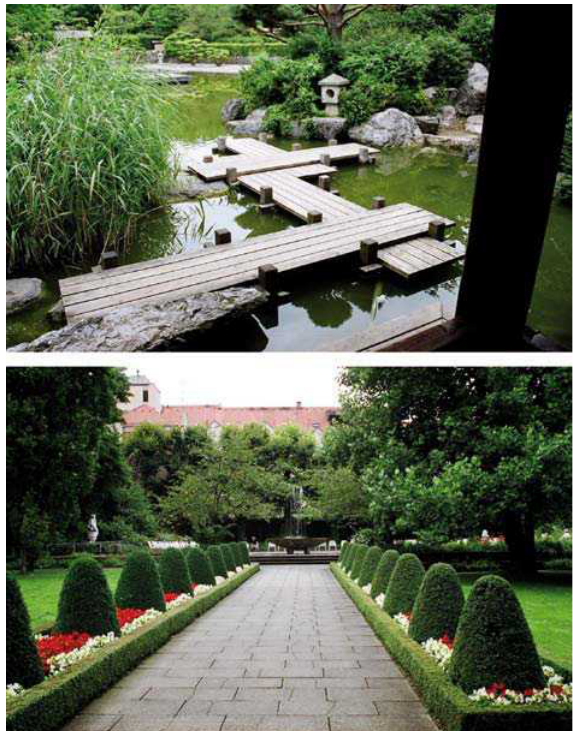
Fig 1. Fragments of German